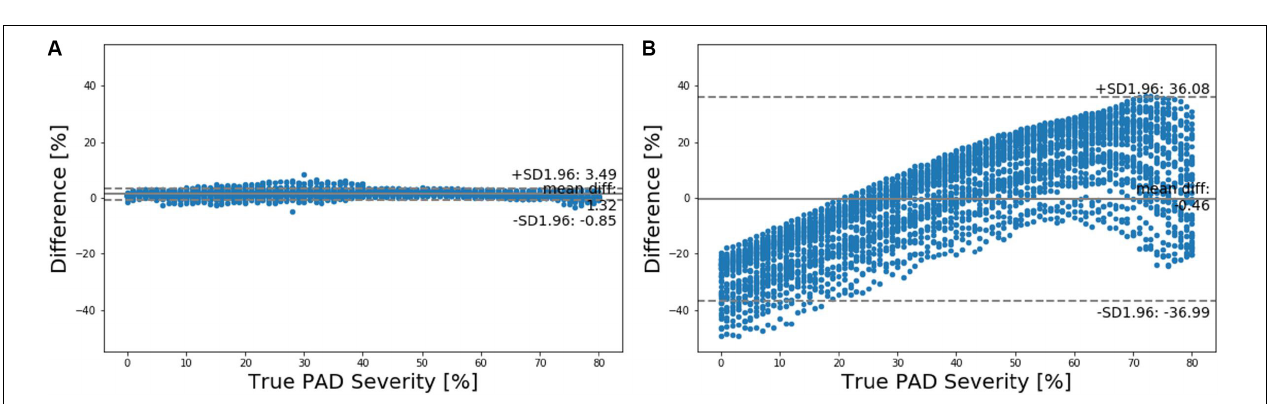
FIGURE 5 | Receiver operating characteristic curves associated with the deep learning-based pulse waveform analysis approach and ankle-brachial index (ABI), both corresponding to varying PAD severity threshold levels for labeling of healthy subjects and PAD patients. (A) DL-based pulse waveform analysis approach. (B) Ankle-brachial index.